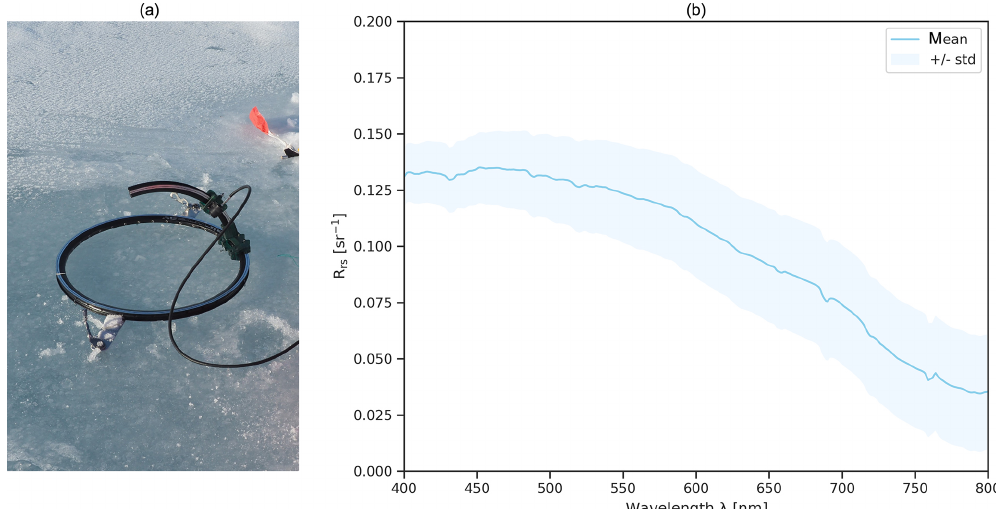
Figure 2. Ibsen bare ice measurement setup (a) . Spectra used in this study (b) were taken at